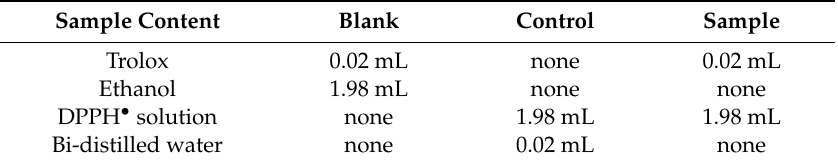
Table 4. Sample composition for the trolox DPPH • assay.